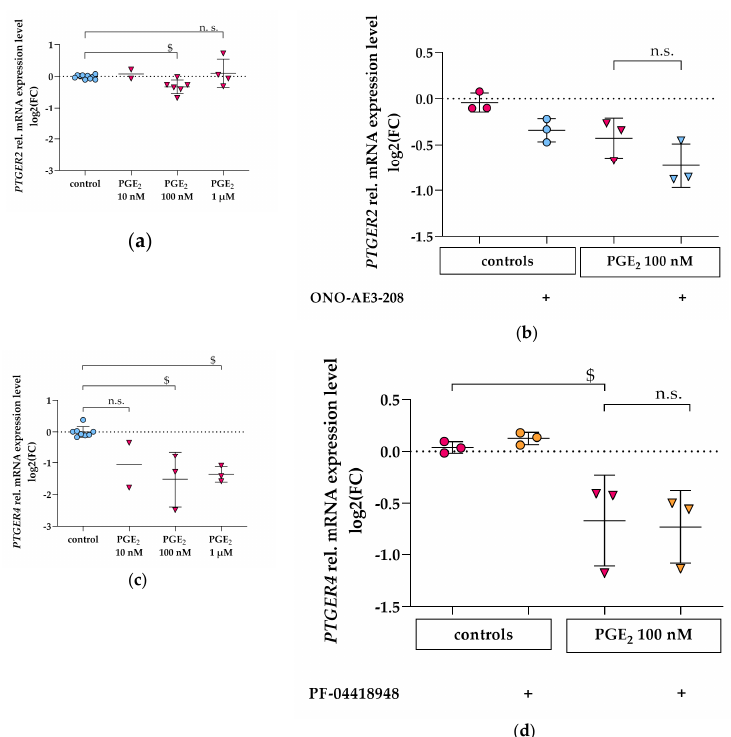
Figure 4. PTGER2 and PTGER4 gene expression in hPC after PGE 2 stimulation and following co-incubation with EP antagonists. qPCR results are presented as relative mRNA expression level normalized to GAPDH and referred to control group. ( a ) PTGER2 levels following PGE 2 stimulation with 10 nM, 100 nM, and 1 µM (pink triangles) for 2 h compared to untreated control (blue circles). Each data point represents the mean of an independent experiment (performed at least in duplicate on different cell passages and on different dates, each consisting of n = 3–8 replicates per treatment) and plotted as combined mean ± SD (horizontal lines). SD was not plotted when only two independent experiments were performed. Statistics: $, p < 0.05, assessed by one-way ANOVA with Dunnett’s follow-up test; ( b ) PTGER2 levels following PGE 2 stimulation for 2 h without concomitant EP4 antagonist (100 nM, pink triangles) compared to controls without PGE 2 (pink circles), and after co-incubation with EP4 antagonist (ONO-AE3-208, 1 µM, blue triangles) compared to controls without PGE 2 (blue circles) obtained in three independent experiments. Each data point represents the mean of an independent experiment (performed in triplicate on different cell passages and on different dates, each consisting of n = 3–6 replicates per treatment) and plotted as combined mean ± SD (horizontal lines). + denotes addition of ONO-AE3-208. Statistics: n .s., not significant, assessed by a Mann–Whitney test; ( c ) PTGER4 levels following PGE 2 stimulation with 10 nM, 100 nM, and 1 µM (pink triangles) for 2 h compared to untreated control (blue circles). Each data point represents the mean of an independent experiment (performed at least in duplicate on different cell passages and on different dates, each consisting of n = 3–8 replicates per treatment) and plotted as combined mean ± SD (horizontal lines). SD was not plotted when only two independent experiments were performed. Statistics: $, p < 0.05, assessed by a Kruskal–Wallis test with Dunn’s multiple comparisons test; ( d ) PTGER4 levels following PGE 2 stimulation for 2 h without concomitant EP2 antagonist (100 nM, pink triangles) compared to controls without PGE 2 (pink circles), after co-incubation with EP2 antagonist (PF-04418948, 1 µM, orange triangles) compared to controls without PGE 2 (orange circles) obtained in three independent experiments. Each data point represents the mean of an independent experiment (performed in triplicate on different cell passages and on different dates, each consisting of n = 5–6 replicates per treatment) and plotted as combined mean ± SD (horizontal lines). + denotes addition of PF-04418948. Statistics: $, p < 0.05; n .s., not significant, assessed by a two-tailed Student’s t -test.